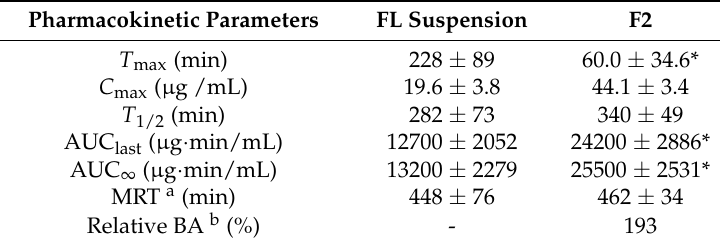
Table 4. Pharmacokinetic parameters of FL after oral administration of FL suspension in 0.3% CMC-Na and F2 formulation, at a dose of 10 mg/kg in rats ( n = 4–5).